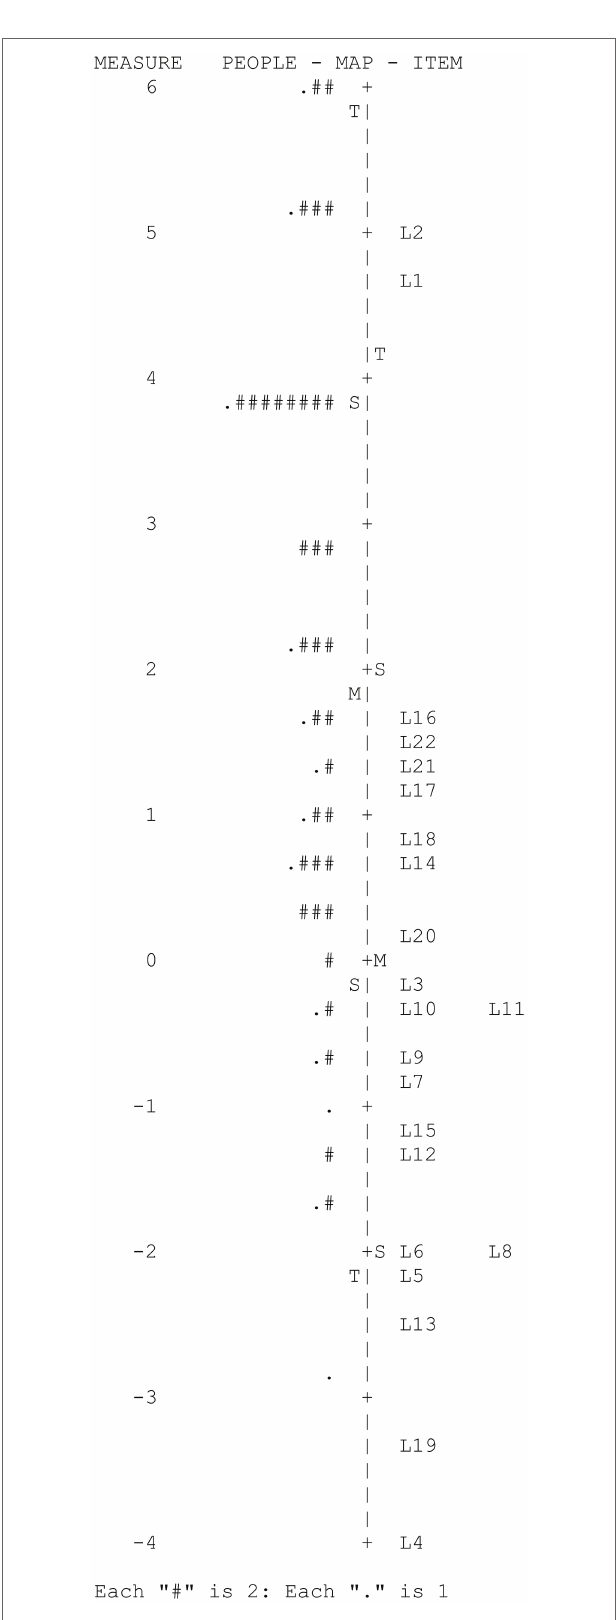
FIGURE 1 | CAPALIST-language. Variable